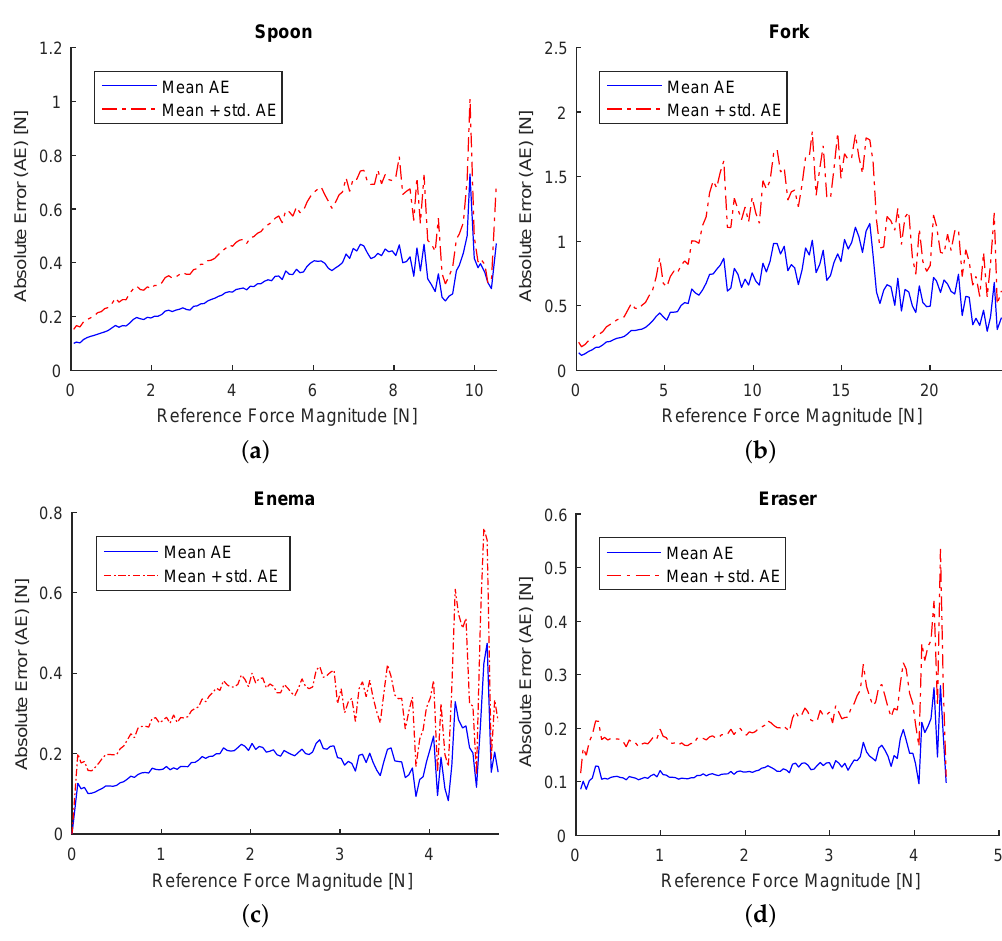
Figure 7. Absolute force error magnitude of approximated signals over the measured force magnitudes for four datasets. ( a ) Absolute error for Spoon dataset; ( b ) Absolute error for Fork dataset; ( c ) Absolute error for Enema dataset; ( d ) Absolute error for Eraser